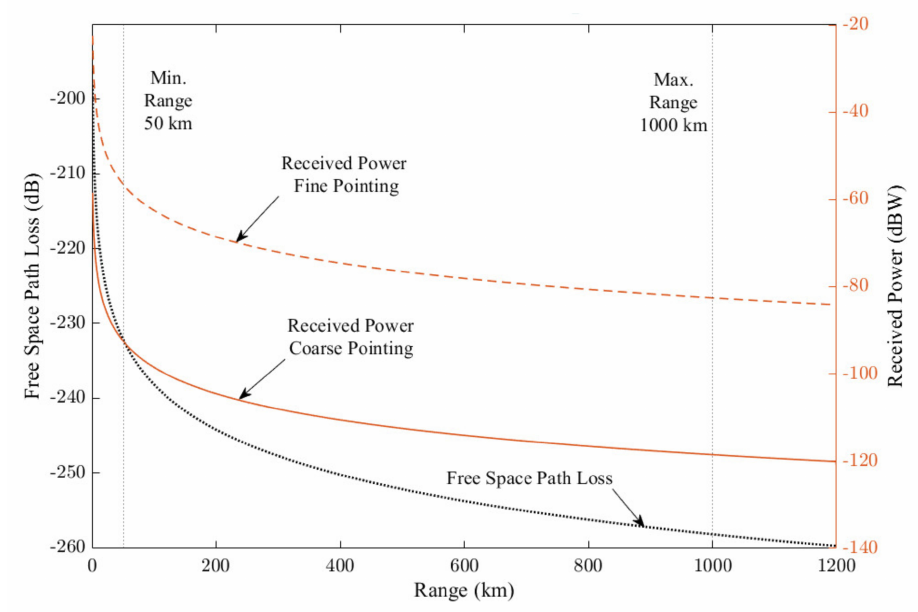
Figure 8. Free space path loss and received power for the laser communication detector over various inter-satellite